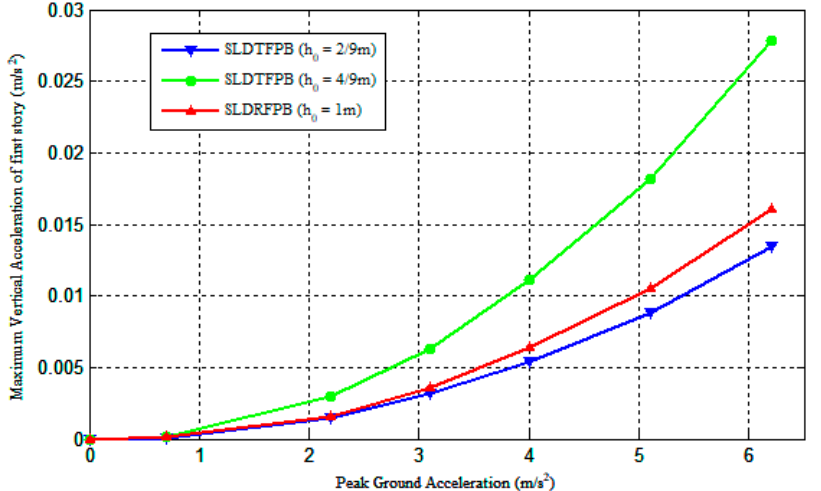
Figure 16. Maximum vertical accelerations of superstructures equipped with SLDRFPB or